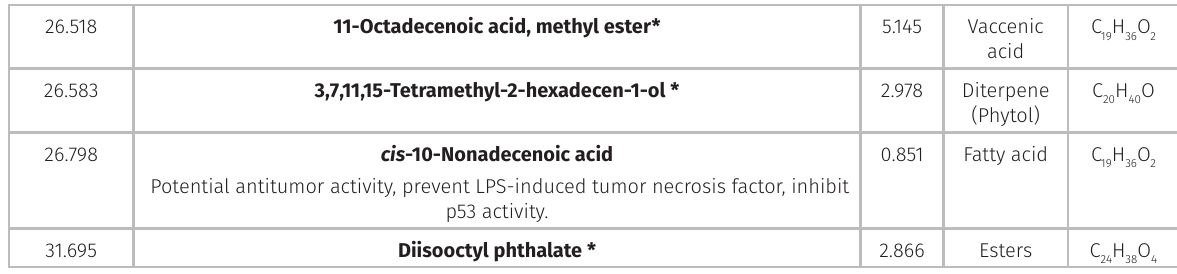
**(Source: Dr. Duke’s Phytochemical and Ethnobotanical Databases). * Activity was mentioned in tables VI or VII.